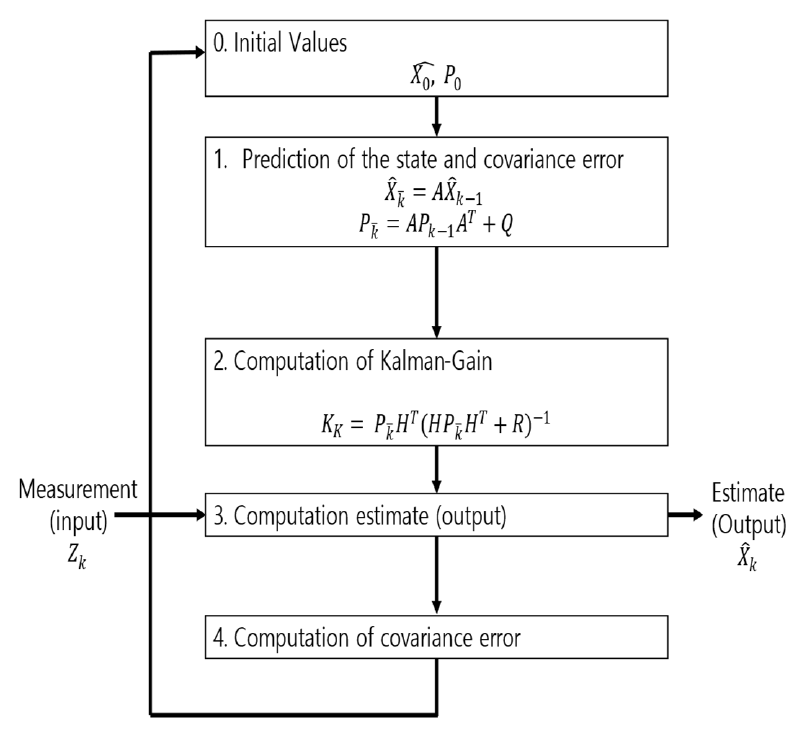
Figure 4. Kalman filter algorithm. Table 1. Variables for Kalman Filter.